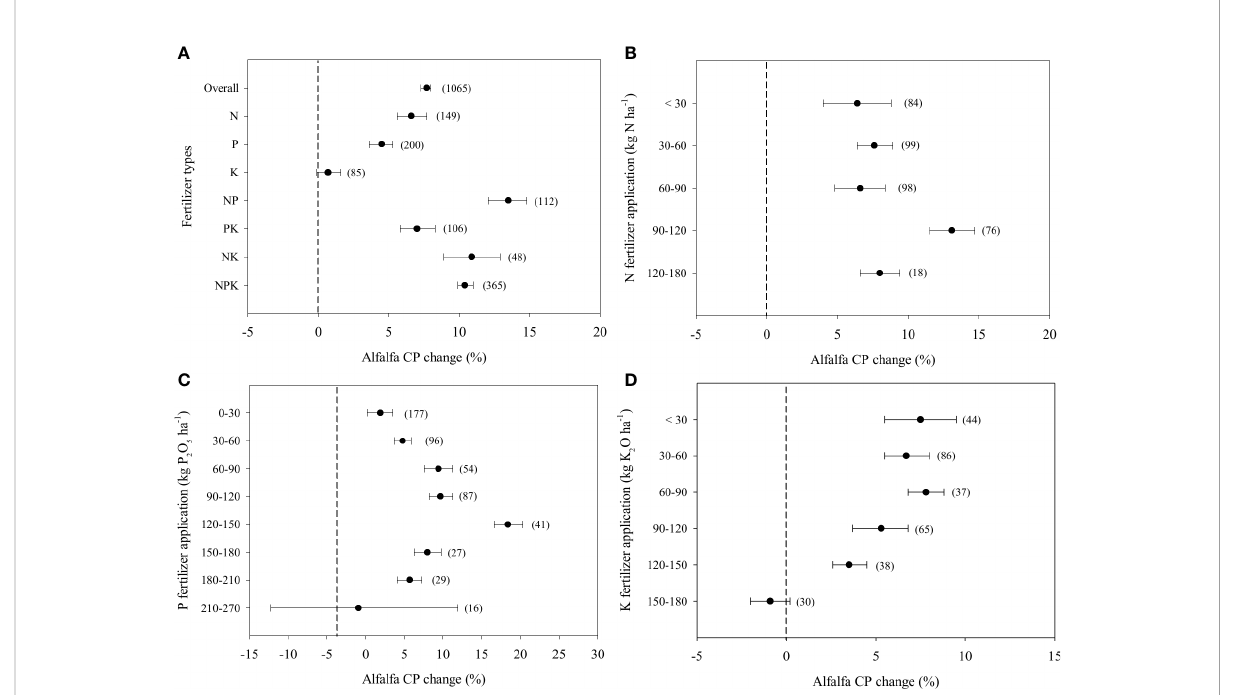
FIGURE 2 Responses alfalfa Crude Protein-CP to different fertilizer combined application (A) and different rates of N (B) , P (as P 2 O 5 ) (C) , K (as K 2 O) (D) fertilizer, expressed as the mean effect size with bias-corrected 95% con fi dence intervals. The number of observations is indicated in